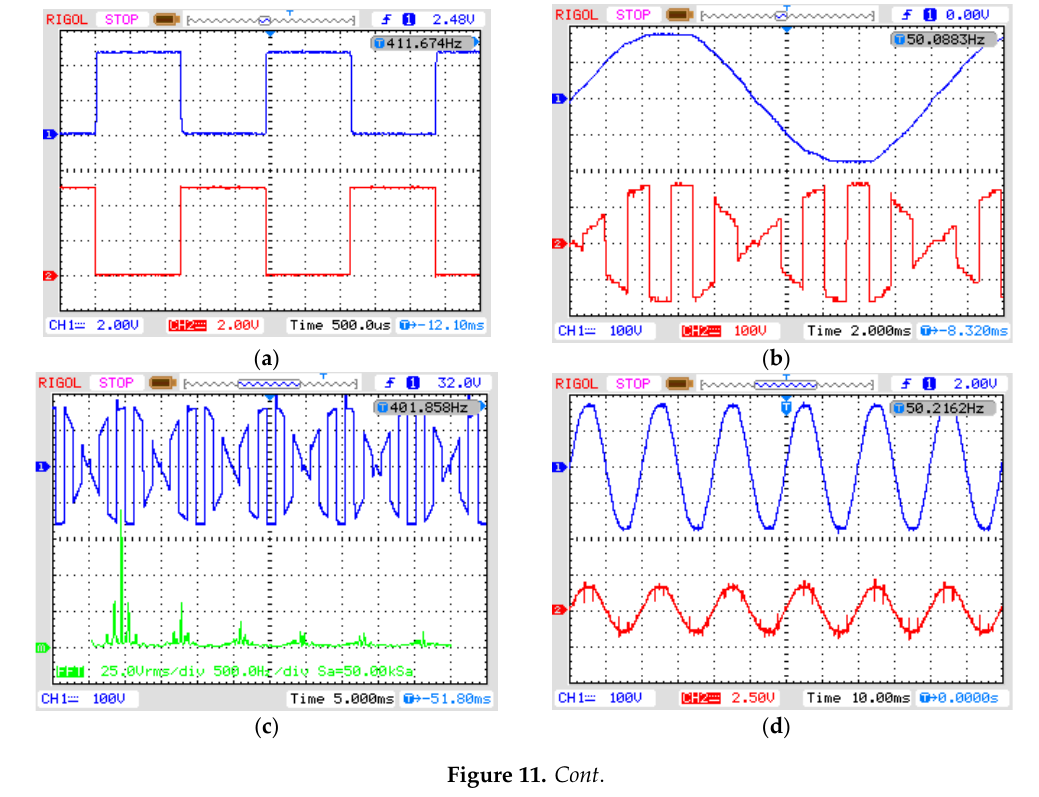
Figure 10. Outputs with zero-crossing detector (ZCD): ( a ) switching signals; ( b ) input-output voltage waveform; ( c ) fast Fourier transform (FFT) of the output voltage waveform; ( d ) input voltage-current waveforms.